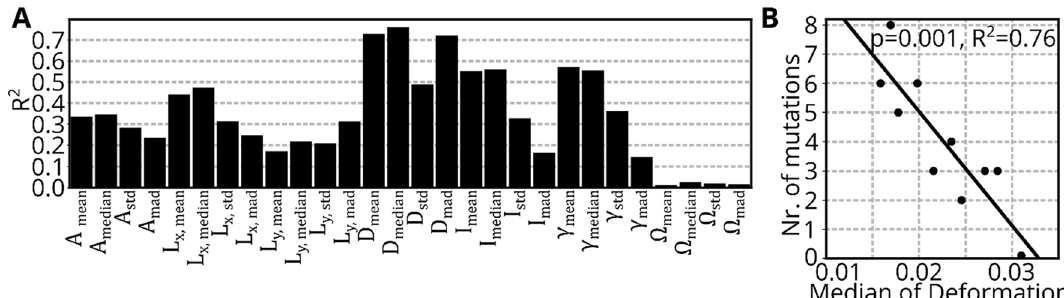
Figure 2. Mechanical properties correlate with number of mutations. ( A ) Barplot shows the square of the Pearson coefficient of correlation (R 2 ), quantifying the association of the number of genetic mutations and distribution features from RT-DC. ( B ) Scatterplot shows the number of mutations vs. the median deformation of 10 MDS samples. The line illustrates a linear fit and the corresponding squared Pearson coefficient of correlation is given in the